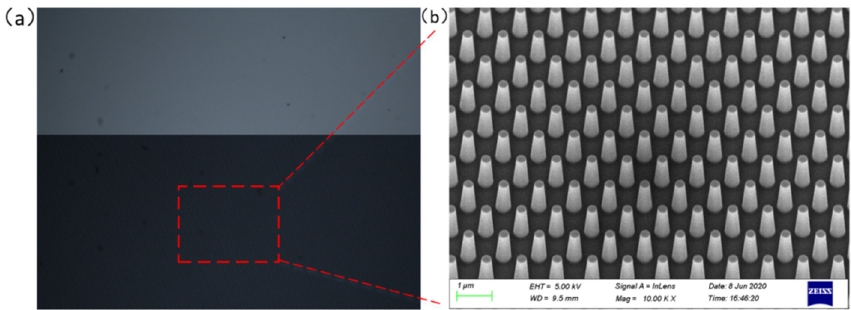
Figure 1. Silicon nanopillar array substrate (NPAS) ( a ) optical image and ( b ) SEM local detail.